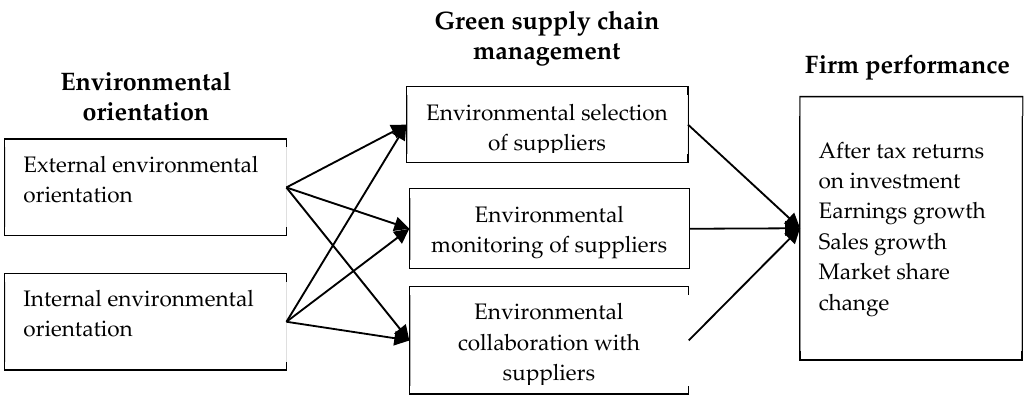
Figure 1. Study framework.